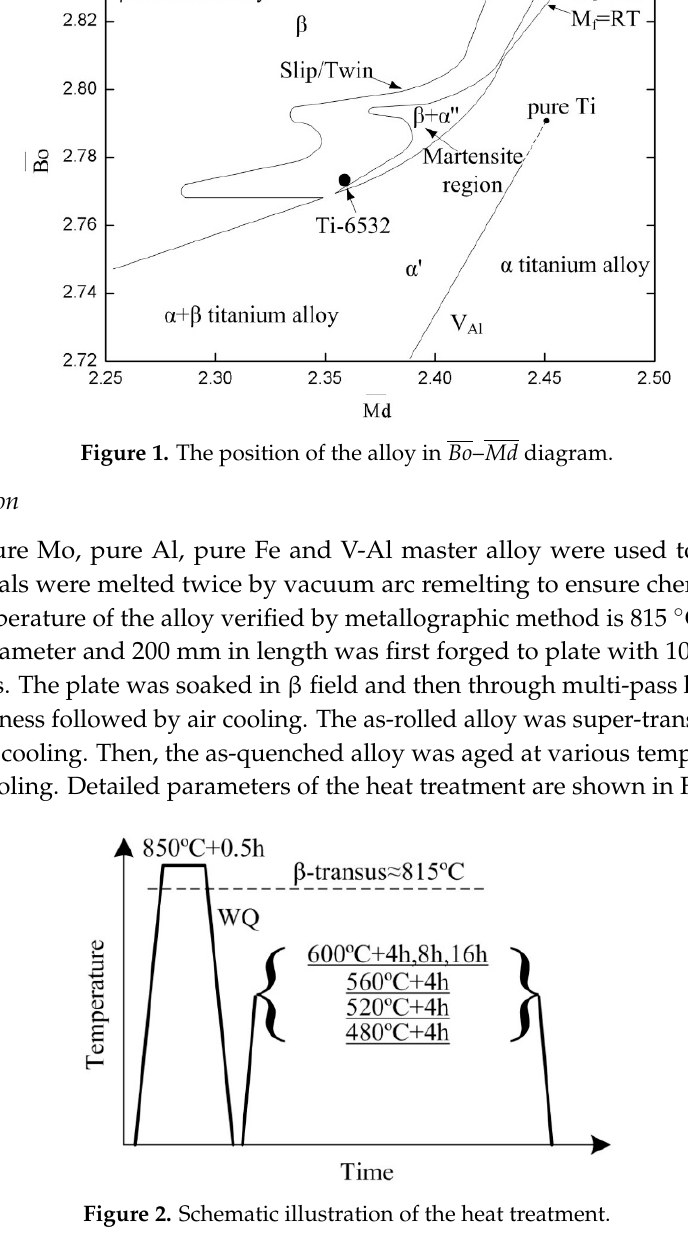
Figure 2. Schematic illustration of the heat treatment.